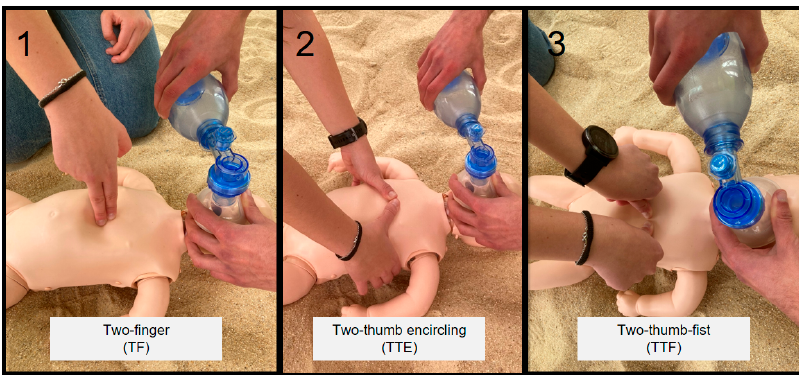
Figure 1. ( 1 ) Two-finger technique, ( 2 ) two-thumb encircling, ( 3 ) two-thumb-fist.